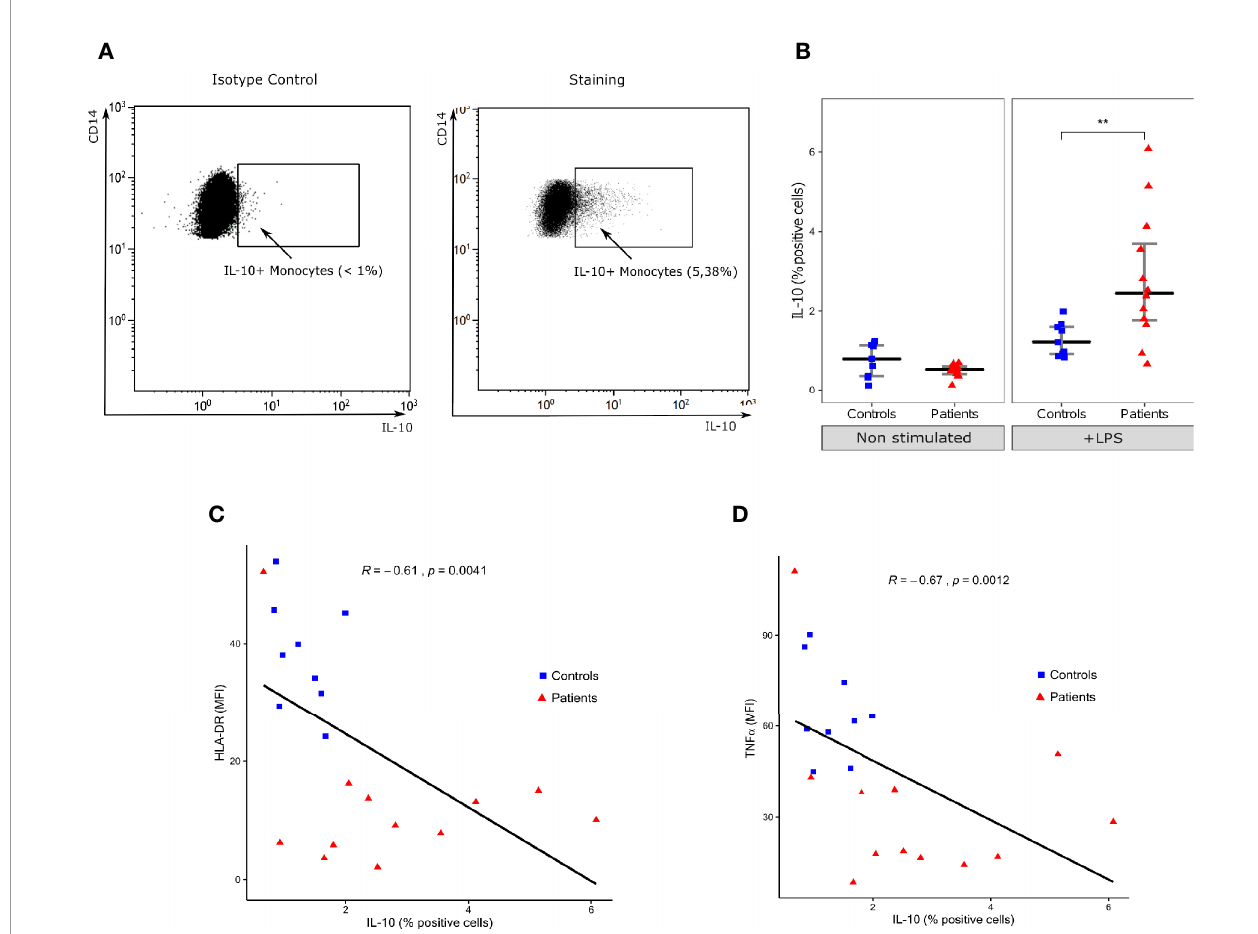
FIGURE 2 | Intracellular IL-10 expression in monocytes. (A) One representative fl ow cytometry dot-plot and its respective isotype control of IL-10 (x-axis) and CD14 (y-axis) in monocytes (gated on CD14+ cells) following LPS challenge in a septic shock patient. Positivity threshold was de fi ned based on isotype value below 1%. (B) Proportion of IL-10 positive monocytes among total monocytes with (+LPS) and without (Non stimulated) LPS challenge. Results are presented as individual values in healthy donors (n=9; blue squares) and septic patients (n = 12; red triangles) and medians ± IQR. **p < 0.01 with Mann-Whitney U test. (C) Scatterplot showing the relationship between monocyte intracellular IL-10 expression (% of positive monocytes, x-axis) and HLA-DR mean fl uorescence intensity (MFI, y-axis). (D) Scatterplot showing the relationship between monocyte intracellular IL-10 expression and monocyte intracellular TNF a expression (MFI). Correlations were analyzed using Spearman correlation coef fi